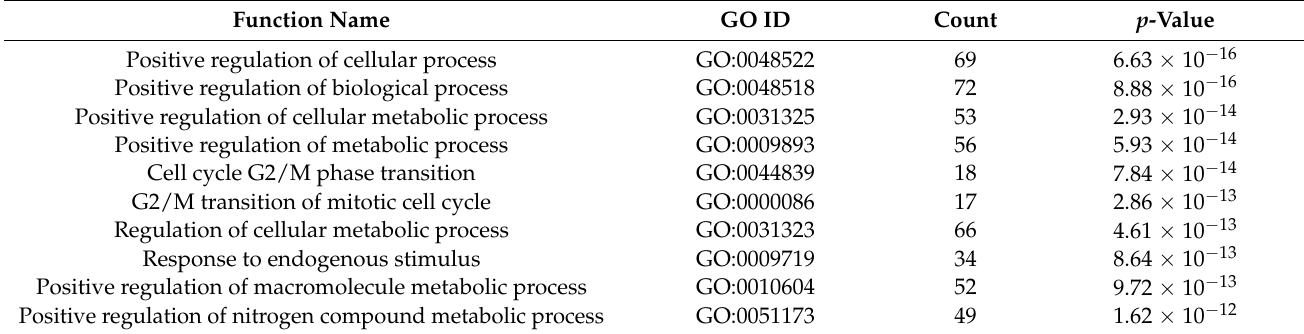
Figure 4. Comparison of the two datasets. ( a ) A Venn diagram comparing differentially expressed genes in anti-Mibyo and anti-Obesity datasets. ( b ) Wnt canonical signaling and ( c ) AMPK signaling were identified using altered genes in the anti-Mibyo dataset. The red and blue colors indicate genes with upregulated and downregulate expression, respectively. Gray denotes genes that were not detected or statistically cut off in the RNA-seq assay. Table 2. The top 10 GO terms were specifically regulated by GTE’s preventive administration in obese zebrafish ( p <